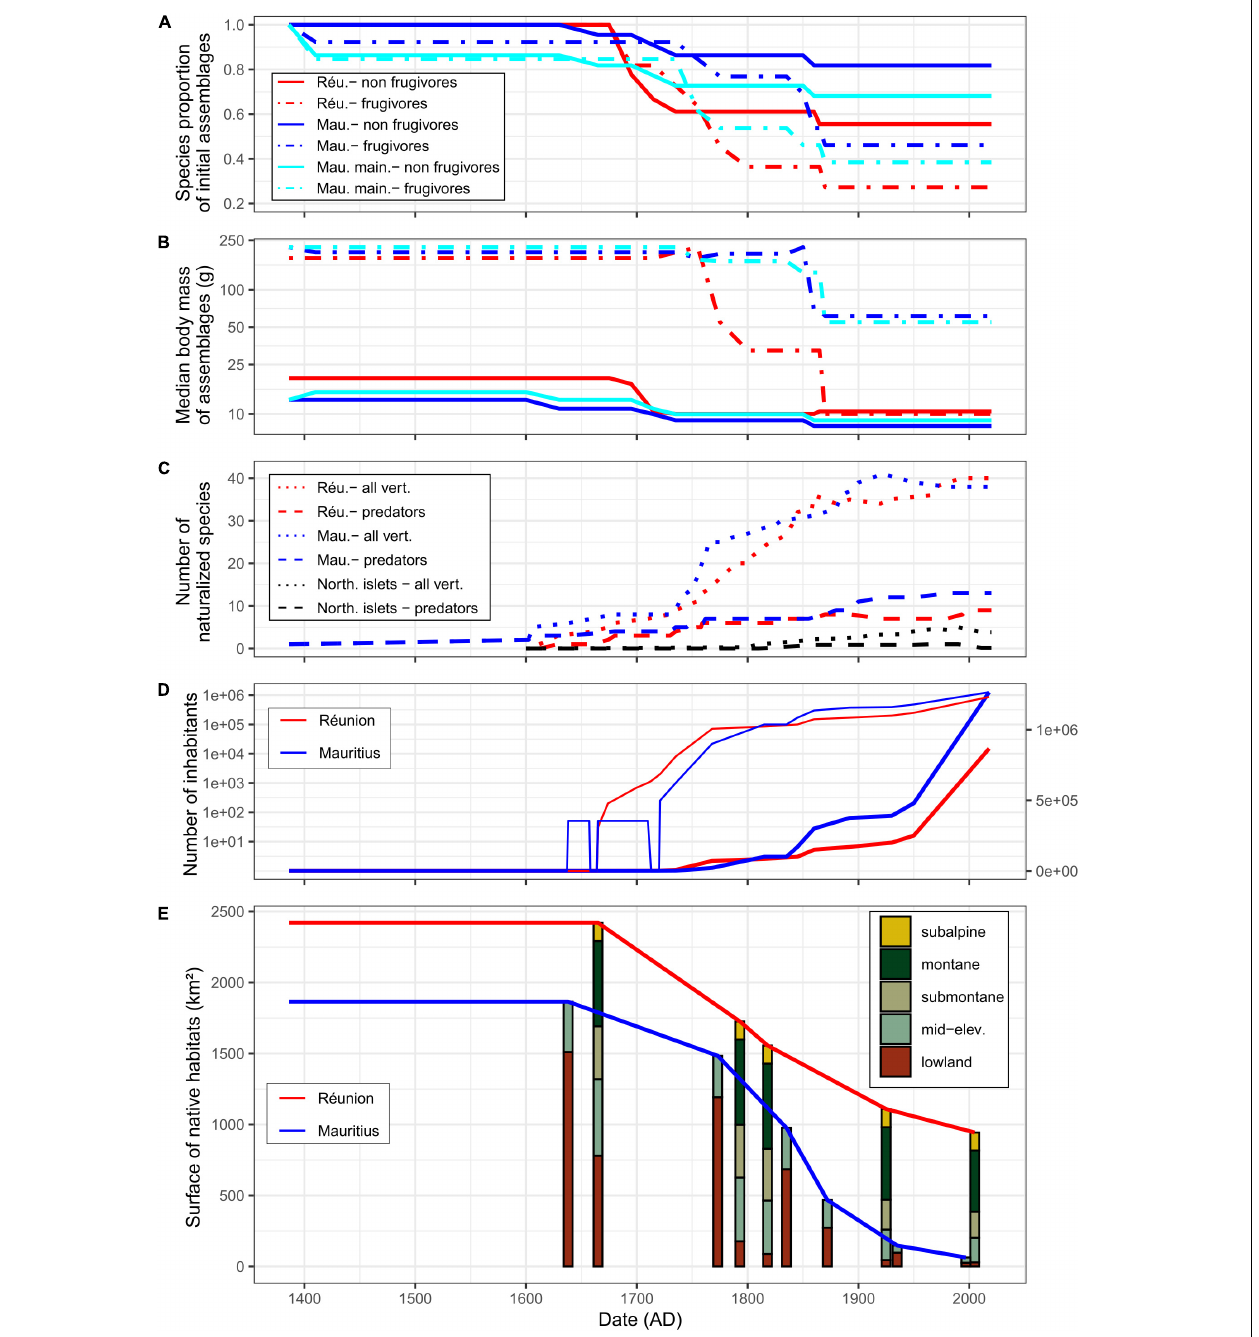
FIGURE 2 | Chronology of extinctions of native forest vertebrates in lineages shared between Réunion and Mauritius (A,B) and of main extinction factors (C–E) since first human arrival. Islands are displayed by colors: Réunion in red, Mauritius in blue (i.e., considering mainland and the northern islets), Mauritius mainland in cyan [panels (A,B) only], northern islets in black [panel (C) only]. (A) Changes in species richness of native frugivores (dotdash lines) and non-frugivores (solid lines) due to extinctions as proportions of initial species assemblages. (B) Changes in median body mass of native assemblages of frugivores and non-frugivores [same legend as in panel (A) ]. Note the log-scale for the y-axis. (C) Changes in the number of vertebrate naturalizations: all land vertebrates (dotted lines) and predators (dashed lines). For the northern islets, the mean number is given. Note the non-monotonicity of the curves which reflects extinctions (for more details, see Supplementary Appendix 1 ). (D) Human population size (bold lines: arithmetic scale on right y-axis, thin lines: log-scale on left y-axis). There are no accurate estimate of the number of Dutch settlers who occupied Mauritius more or less permanently during the 17th century. Similarly, after the abandonment of Mauritius by the Dutch, the